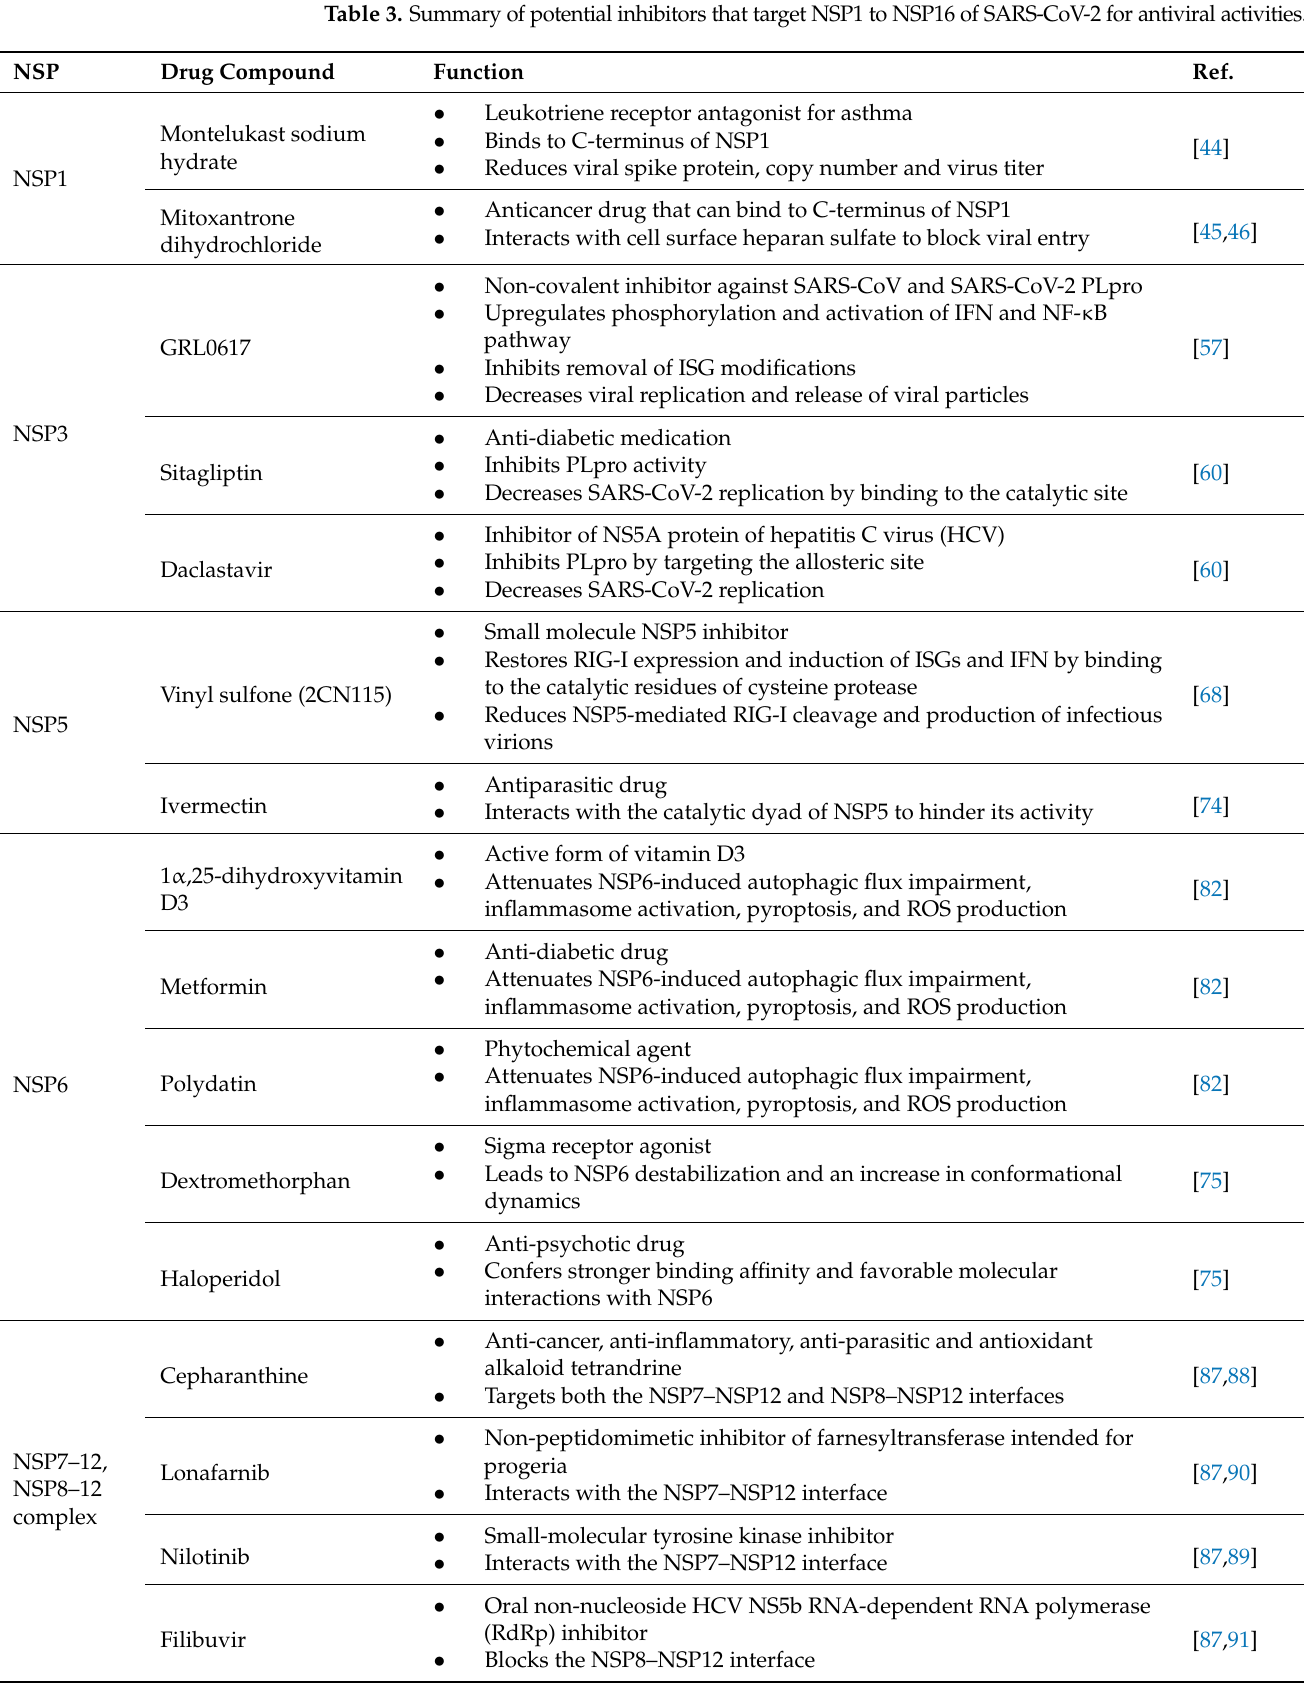
Table 3. Summary of potential inhibitors that target NSP1 to NSP16 of SARS-CoV-2 for antiviral activities. NSP Drug Compound Function